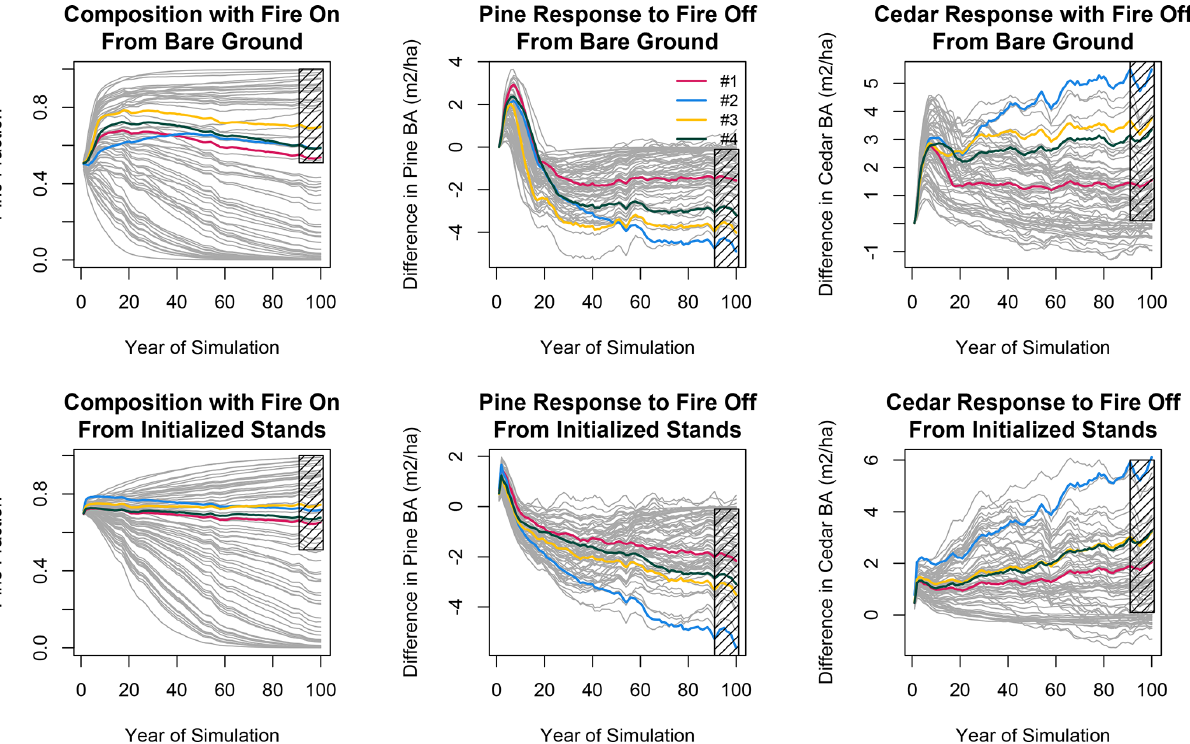
Figure 3. Ensemble predictions relative to six of the filters based on ecological expectations listed in Table 2. Each simulation (lines) had a unique PFT parameterization. Black hatched areas indicate the range of expected outcomes. Colored lines indicate simulations that were retained and gray lines indicate those excluded after applying all eight